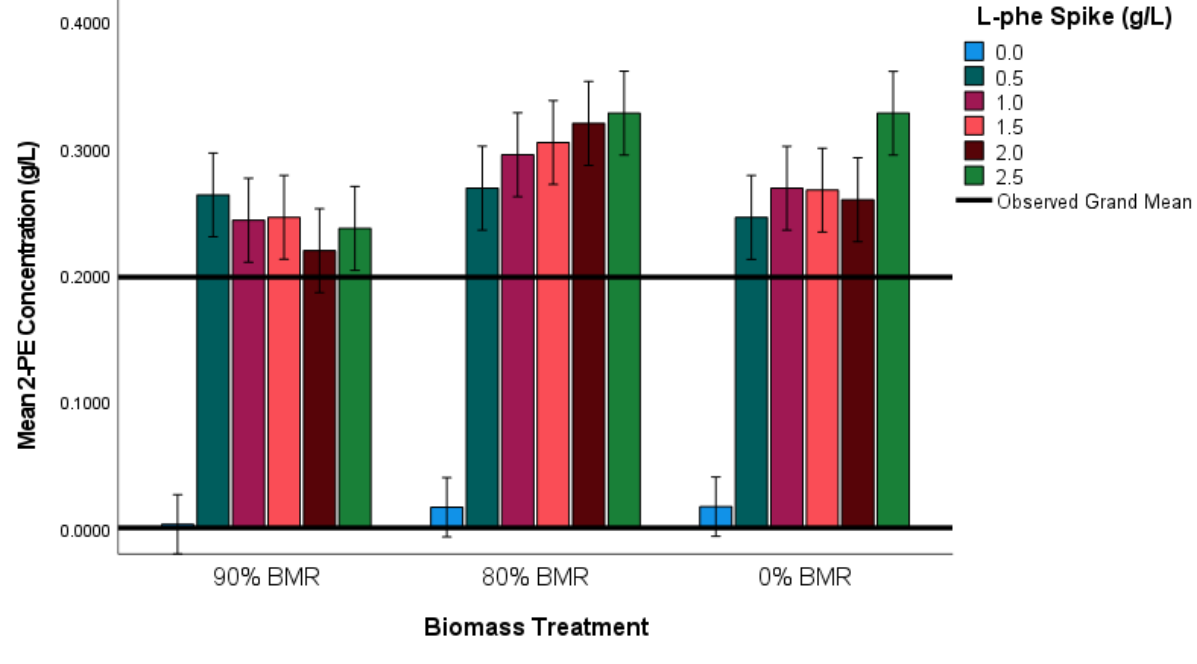
Figure 5. Bar graph indicating the average 2-PE concentration of each treatment combination with error bars representing the 95% confidence interval. Note that the 0.0 g L − 1 L-phe spike in all biomass treatments has significantly less 2-PE than any other spikes. Additionally, the 80% BMR treatment shows a gradual, consistent increase in 2-PE with L-phe spike, while the 90% BMR and 0% BMR treatments appear more random.